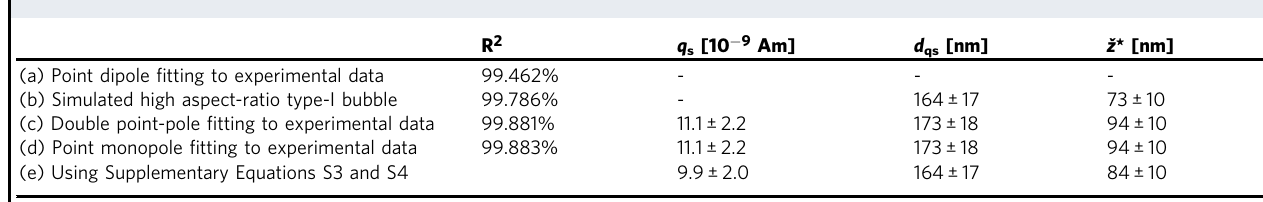
Table 1 Evaluation of a single magnetic bubble.